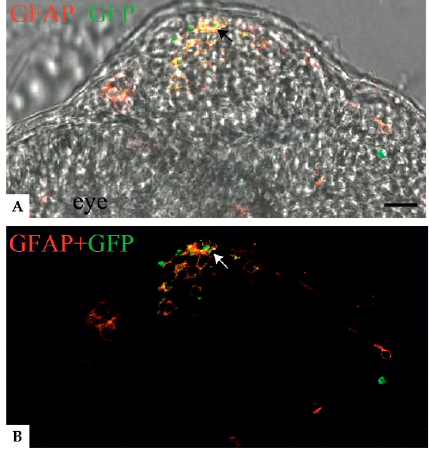
Figure 4. Confocal images showing colocalization between anti-GFAP signal and the GFAP R239C-GFP aggregates in zebrafish transverse sections of 24 hpf embryos. ( A , B ) Confocal images showing p.R239C aggregates (green) labeled by anti-GFAP antibody (red). A clear colocalization (yellow) (black and white arrows respectively in A and B) is visible in most of the cells containing green aggregates. ( A ) Confocal image imposed on a brightfield image of the same region. Scale bar: ( A , B ) 30 µ